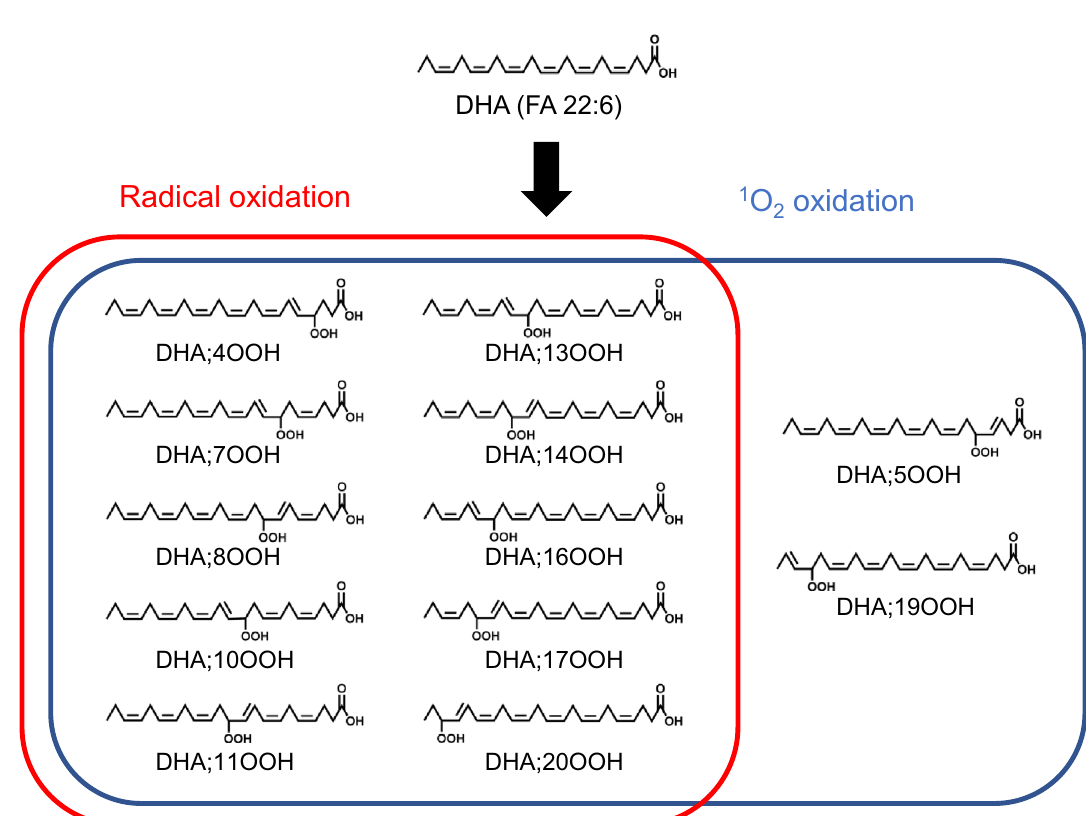
Figure 1. DHA;OOH isomers formed by radical- or 1 O 2